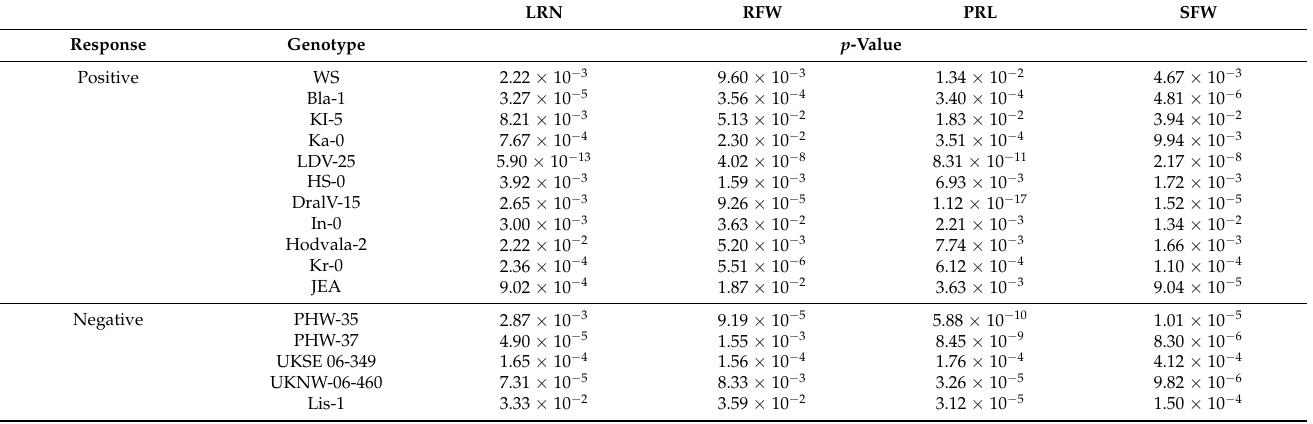
Figure 3. Phenotyping of Arabidopsis accessions for responsiveness to DQS-4T mediated effect in root fresh weight (RFW). Agar plates with five seedlings showing the different response of Arabidopsis accessions to Azoarcus olearius . ( A , B ) Accessions that increased RFW upon DQS-4T treatment. ( C , D ) Non-responsive accessions to bacteria treatment. ( E , F ) Accessions where RFW was inhibited by DQS-4T treatment. Bars are an average of three biological replicates (n = 15). Statistical analysis was carried out using one-way ANOVA with Tukey’s test p -value < 0.05 (* p ≤ 0.05; ** p ≤ 0.01; *** p ≤ 0.001). RFW = root fresh weight. Photographs were taken by scanning the plates using a photo scanner with resolution 640 × 480. Table 1. Genotypes with statistical significance for the four plant growth parameters measured with regard to DQS-4 T